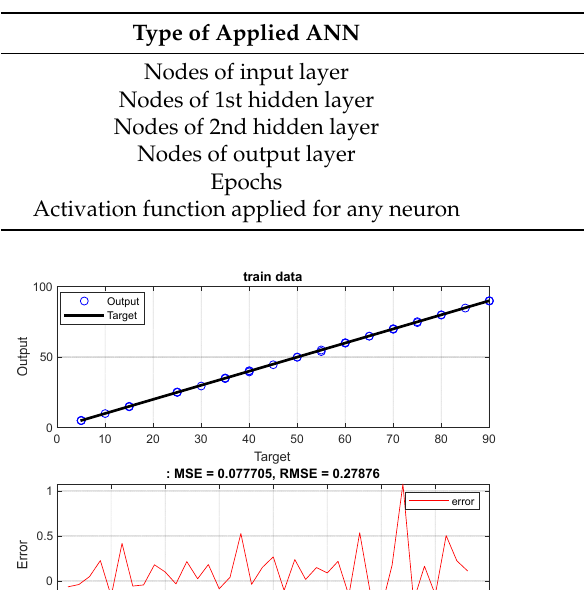
Table 2. Properties of the implemented network.